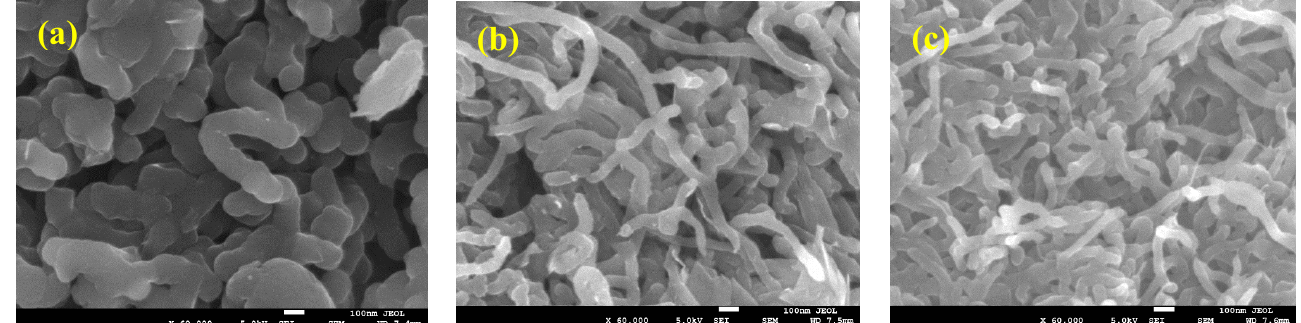
Figure 1. ( a – c ). Scanning electron microscopy (SEM) image of polypyrrole/multiwalled carbon nanotubes composites (PPy/MWCNTs) composite thin films.